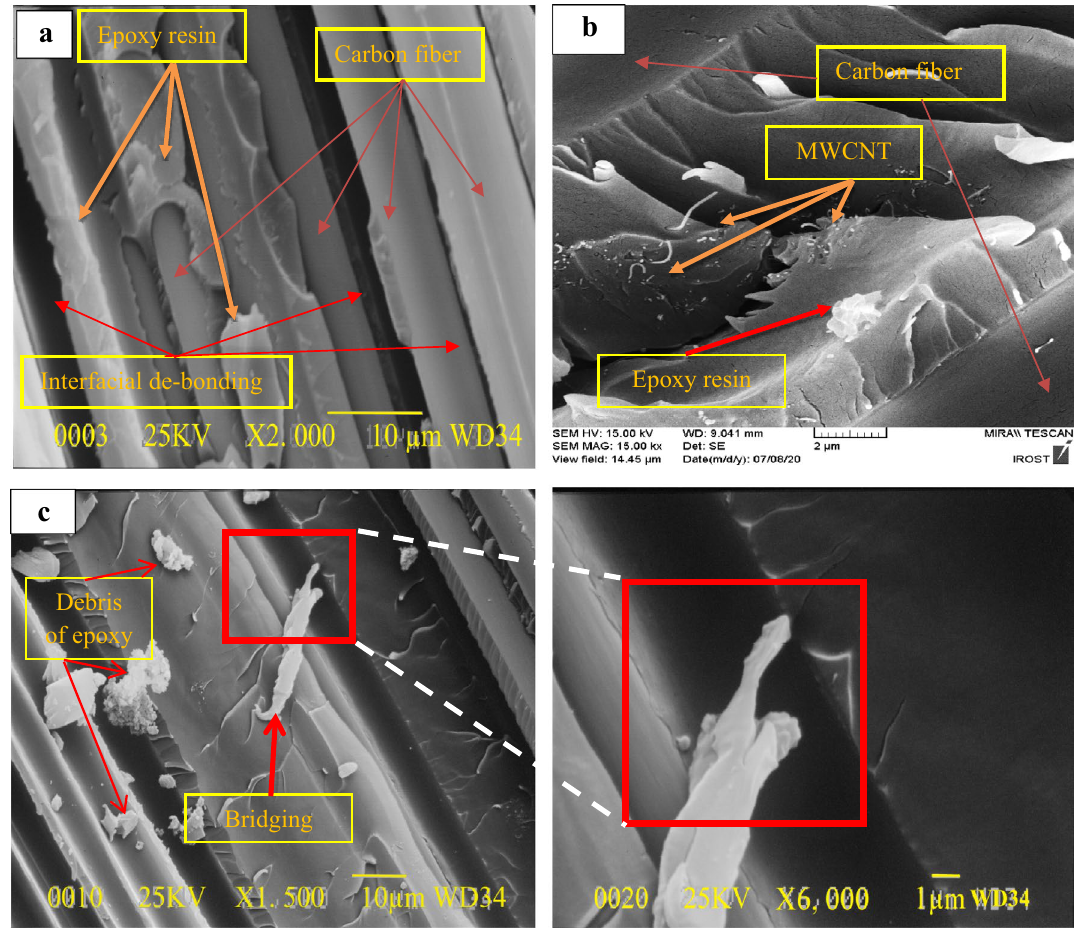
Fig. 7 SEM images of the fracture surfaces of ( a ) epoxy/CF laminate composite and ( b , c ) epoxy/MWCNT/CF hybrid